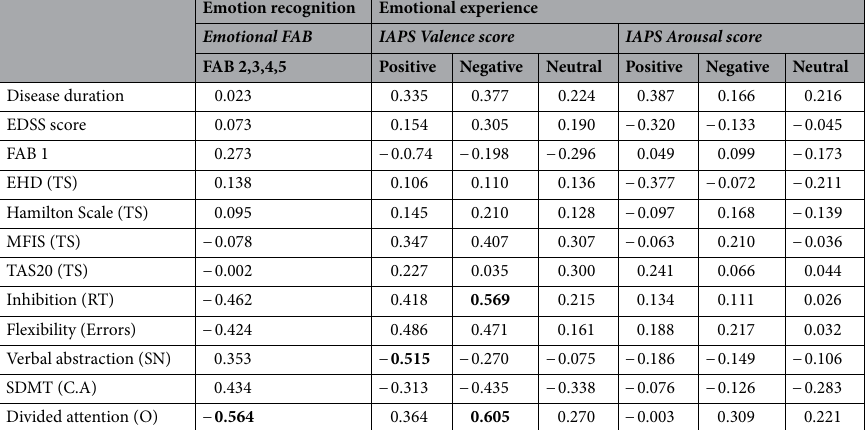
Table 4. Correlational analysis of patients in the MS group. TS total score, RT reaction time, O omission, C.A correct answers, IAPS International Affective Picture System, FAB Florida Affect Battery, EDSS